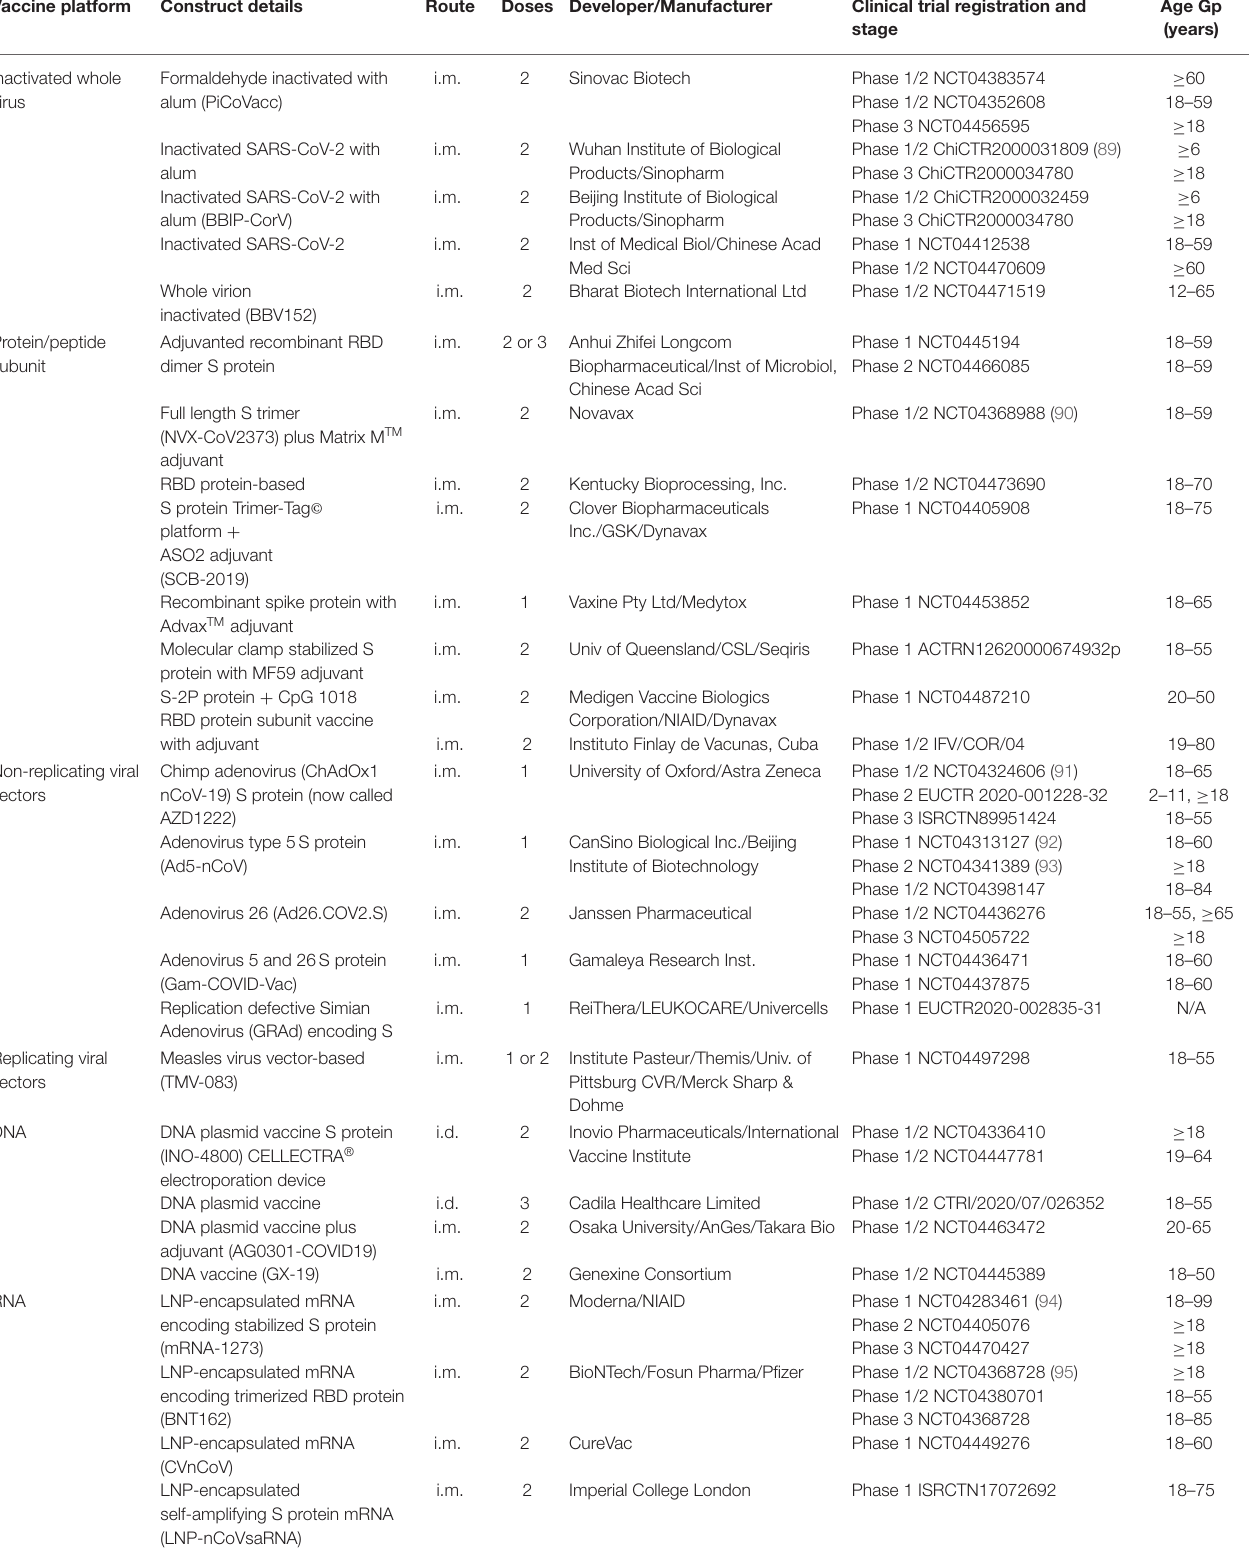
TABLE 2 | Candidate SARS-CoV-2 vaccines currently in clinical